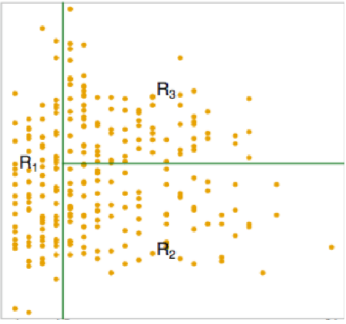
Figure 2. The partition of data in